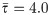
Interspike-time and frequency-count histograms of a simulation of free Brownian vesicles.(A), (C) Interspike-time histograms f(δt) and f(δτ) before and after time rescaling, respectively. (B), (D) frequency-count histograms P(k) (for a time interval of T = 2.7 s width) and P(κ) (for a rescaled time interval of τ¯=4.0 width) before and after time rescaling, respectively. The histograms f(δt) and f(δτ) are fitted with gamma (solid lines) and exponential distributions (dashed lines). The frequency-count histograms P(k) and P(κ) are fitted with the gamma-count- (see text, solid lines) and Poisson distributions (dashed lines). The number of spikes was 15504. Inset plots in (A) and (C) show the spike rates of the original and time rescaled spike series, respectively.